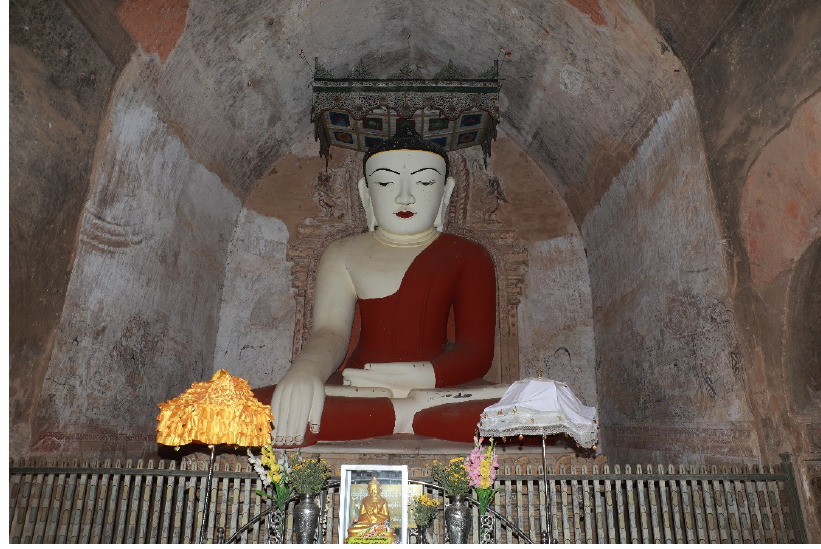
Figure 2. The Buddha seated in bh ū mispar ś amudr ā , symbolizing the enlightenment and the first week, Sulamani temple, Bagan.